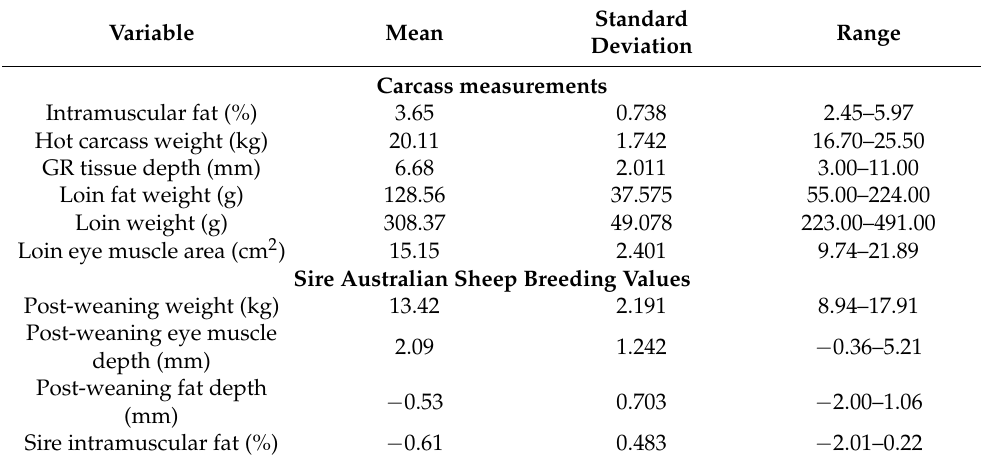
Table 1. Descriptive statistics of carcass measurements and sire Australian Sheep Breeding Values. Variable Mean